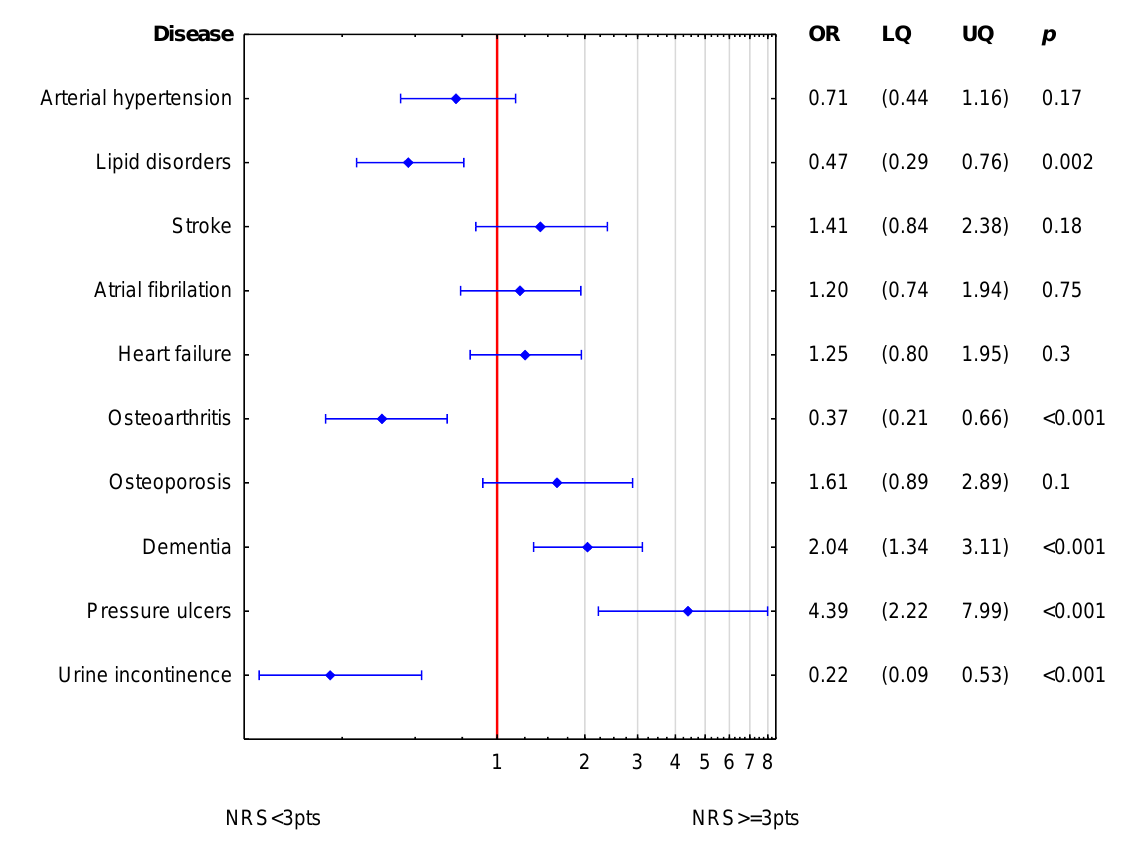
Figure 3. Simultaneous association of accompanying diseases to NRS-2002 in men. (OR odds ratio; LQ—lower quartile; UQ—upper quartile; p — p value). Reference value (OR = 1; red line) corresponds to the absence of particular disease. Blue symbols correspond to odds ratios and 25–75% confidence intervals for the presence of particular disease